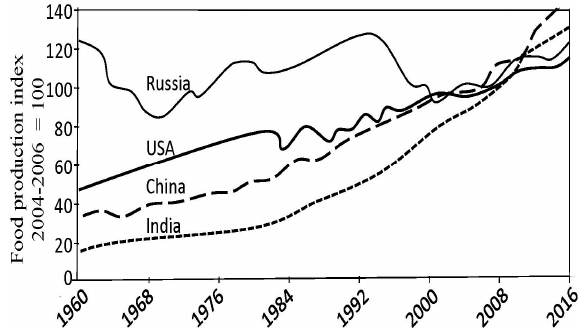
Figure 2. Food production indicators in major countries.